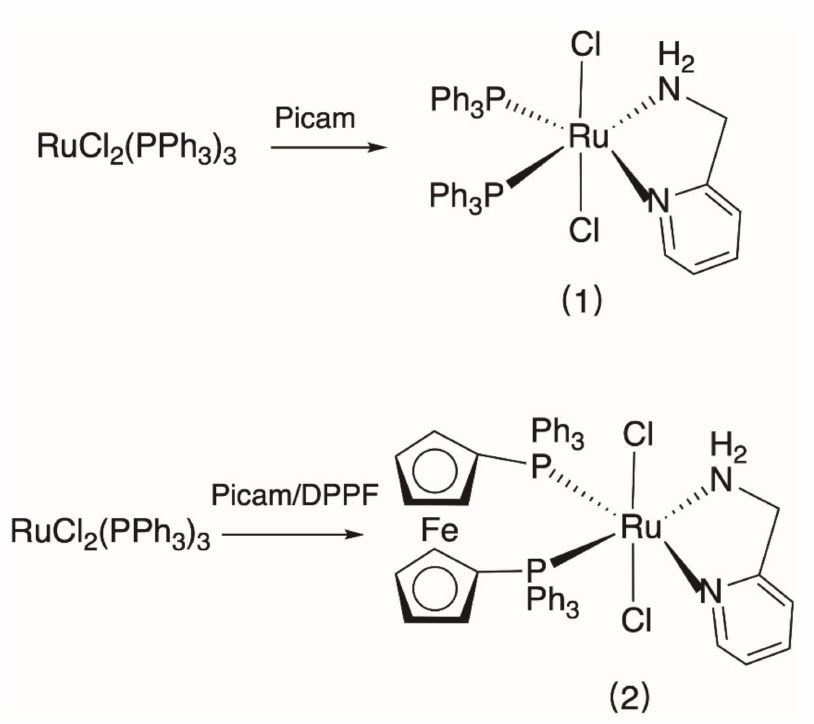
Figure 1. The synthesized procedure of trans -Ru(II)Cl 2 (P) 2 (N) 2 complexes ( 1 ) and ( 2